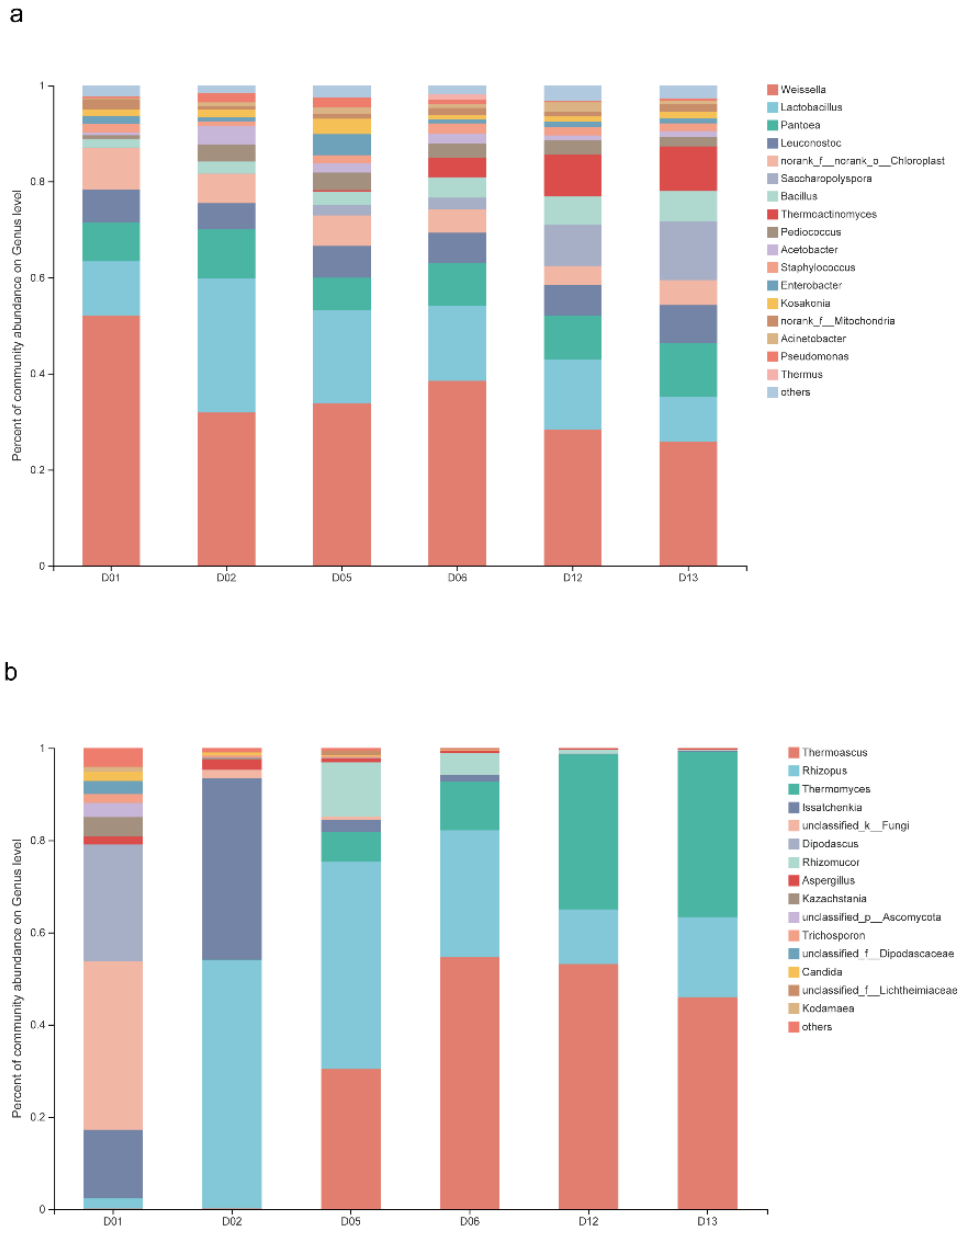
Figure 1. Daqu microbiota composition during fermentation. Bar plots of bacterial genera ( a ), fungal genera ( b ), and “others” include all taxa <0.01%.